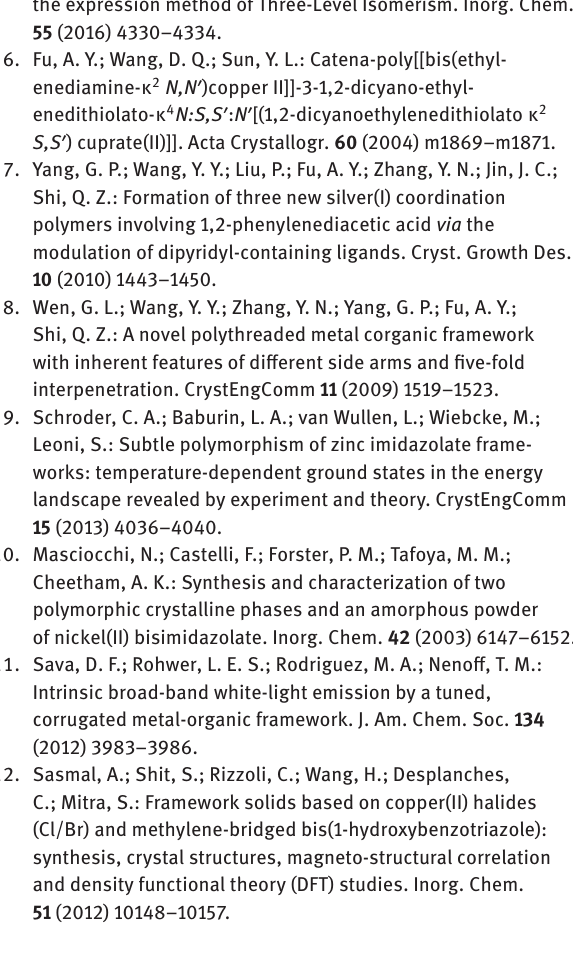
The asymmetric unit of the title structure contains one half of a Cu(II) ion, two half chlorine anions, and one neutral imidazole molecule. Each Cu (II) atom is five- coodinated by three chlorine anions and two imidazole N atoms. The Cu—N bond length is 1.966(4)Å, whereas the three different Cu—Cl bond lengths range from 2.310(2) to 2.772(2)Å. The coordination environment is a distorted trigonal bipyramid, since the Cl—Cu—Cl bond angles in the triangular plane are within the range of 92.27–167.68°. The C2 and N2 atoms in a imidazole molecule are